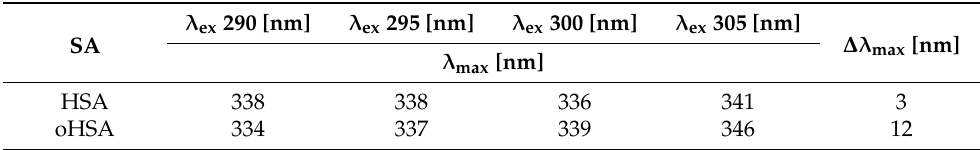
Table 2. Fluorescence of unmodified (HSA) and oxidized (oHSA) human serum albumin at 5 × 10 − 6 mol · L − 1 concentration; the excitation wavelengths λ ex 290 nm, λ ex 295 nm, λ ex 300 nm, λ ex 305 nm.